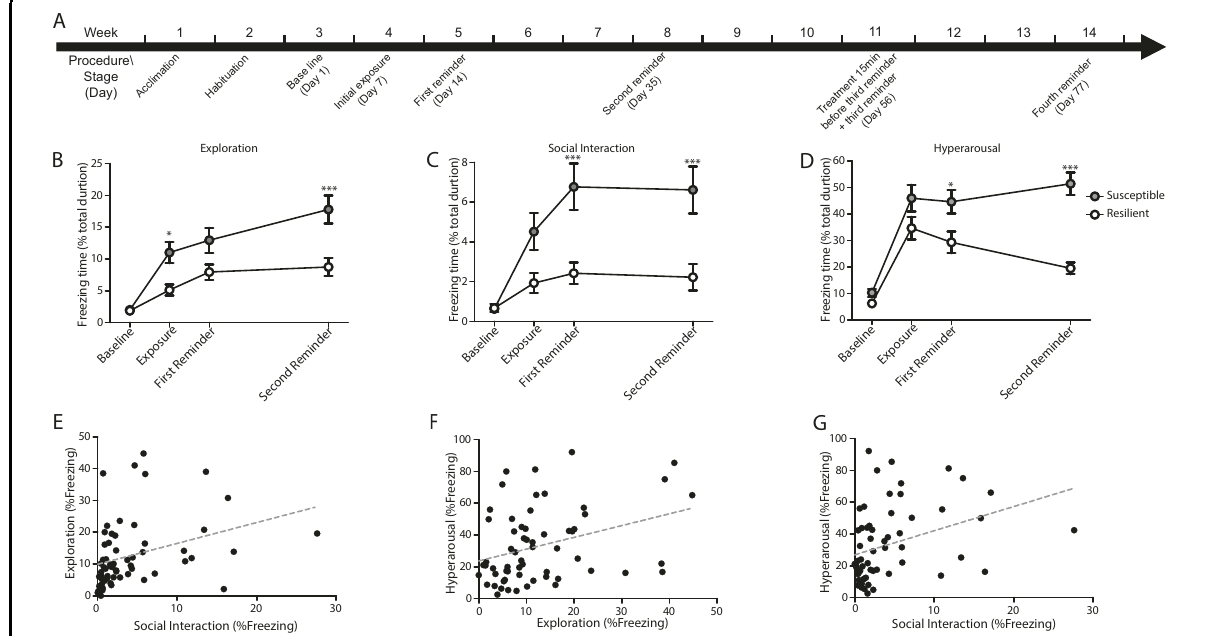
Fig. 1 Behavioral response in the PTSD model. ( A ) Schematic depiction of the experimental model. The animals began the experimental procedure after two weeks of acclimation and habituation to the home cage and the open fi eld. Baseline response to the three behavioral scenarios was monitored on day 1. Day 7: Exposure to ‘ trauma ’ (Initial exposure). Day 14: fi rst exposure to the ‘ trauma ’ s ’ reminder ( ‘ fi rst reminder ’ ). Day 35: second exposure to the ‘ trauma ’ s reminder ( ‘ second reminder ’ ). Day 56: third exposure to the ‘ trauma ’ s reminder ( ‘ third reminder ’ ). Day 77: fourth exposure to the ‘ trauma ’ s reminder ( ‘ fourth reminder ’ ). ( B ) Freezing behavior during: exploration, ( C ) social interaction, and ( D ) hyperarousal tests. After exposure to trauma and the reminders, susceptible but not resilient animals showed an increase from baseline in freezing behavior, i.e., incubation of fear over time in all three behavioral tests (exploration: * p < 0.05 and *** p < 0.001 susceptible vs. resilient; social interaction: *** p < 0.001 susceptible vs. resilient and hyperarousal: * p < 0.05 and *** p < 0.001 susceptible vs resilient). Data presented as mean ± SEM; n = 26 – 35 per group. ( E – G ) Pearson ’ s product-moment correlation between the following tests: ( E ) exploration×social interaction, ( F ) hyperarousal×exploration, and ( G ) hyperarousal×social interaction ( r > 0.33; * p <